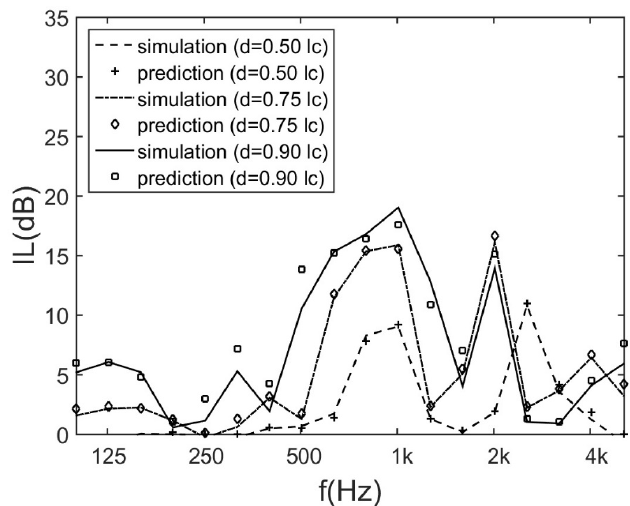
Figure 8. Values of IL index of sonic crystals noise barriers with different scatterer diameters. The lines correspond to 3D numerical simulations [22]. Lines with marks correspond to predictions using the model proposed in this paper (Equation (5)). Three values of the scatterers’ diameter (d) are plotted relative to the lattice constant (lc). (d = 50%, 70% and 90% of the lattice constant).